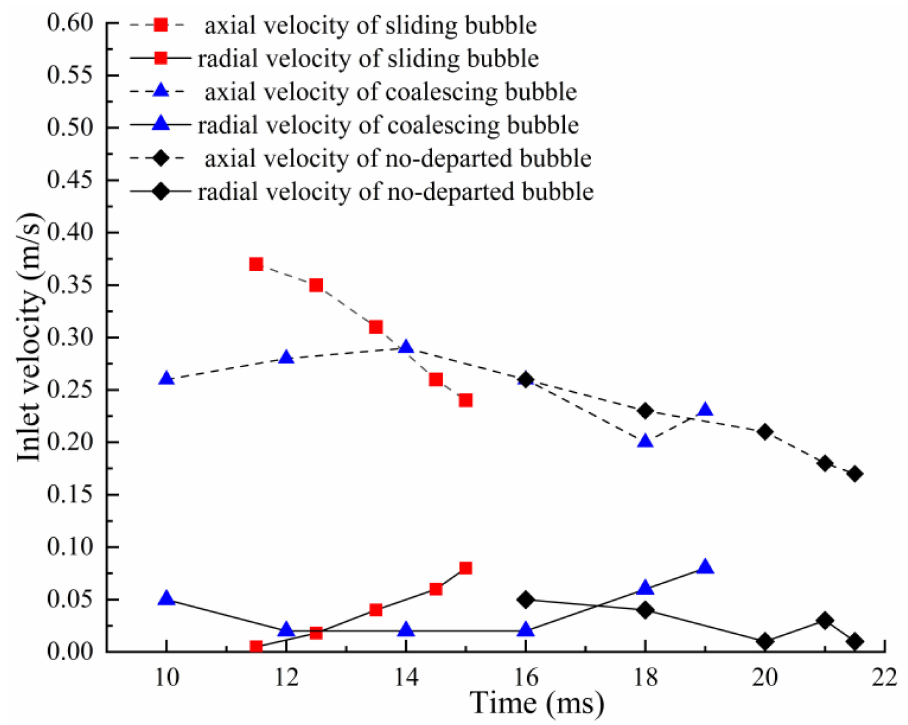
Figure 8. The trend of axial and radial velocities of a sliding bubble, a coalescing bubble and a non-departed bubble during